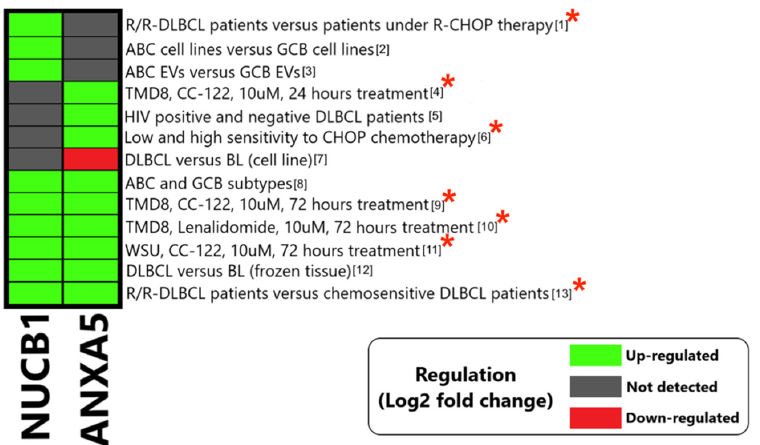
Figure 3. Heatmap summarizing the regulation of the two most consistently identified and up-regulated proteins (ANXA5 and NUCB1) in articles that identified them as the significantly regulated proteins. Colors are coded based on the protein direction of regulation and the score of 0 (black) indicates those studies that did not identify ANXA5 or NUCB1 proteins. The red stars show studies that tested drug effects on samples of DLBCL patients or cell lines. R/R: relapse/refractory, TMD8: Tokyo medical and dental university 8 (cell line), CC-122: cereblon E3 ligase modulator avadomide; WSU: Wayne State University (Table S1).